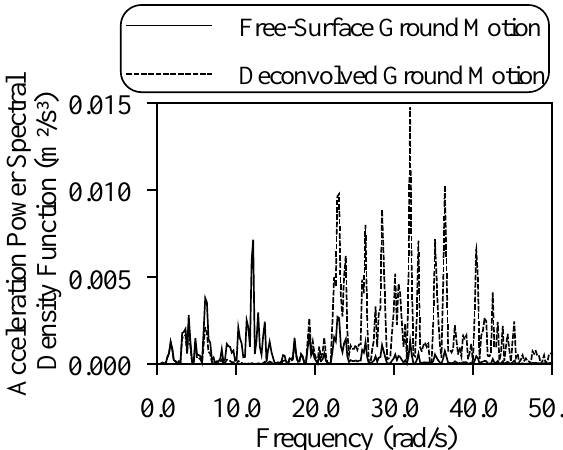
Fig. 7. Acceleration spectral density function of the free-surface Fig.7. Acceleration spectral density function of the free-surface and deconvolved ground acceleration and deconvolved ground acceleration for the 1999 Kocaeli earth- for the 1999 Kocaeli earthquake